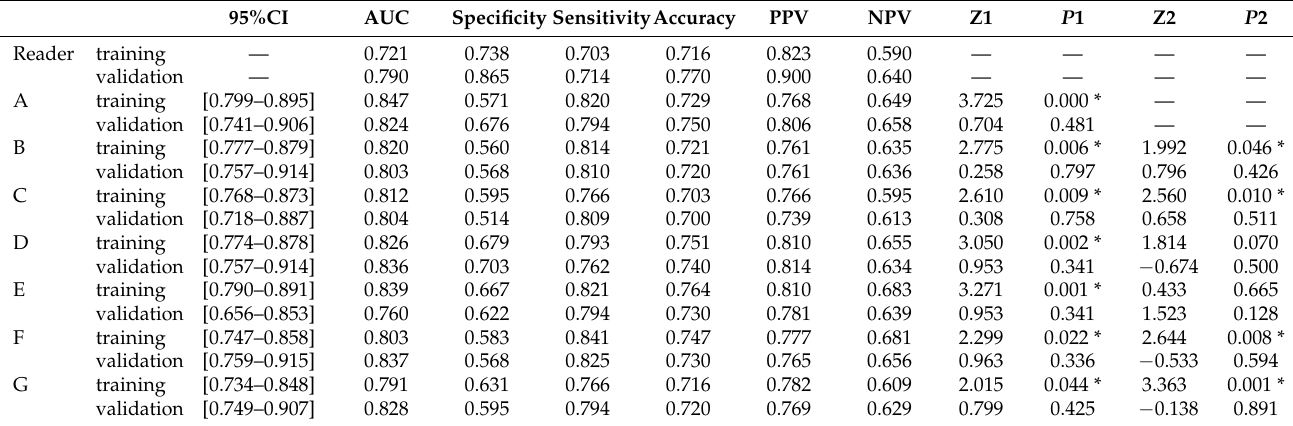
Table 4. The performance of 7 radiomics models in staging NPC.